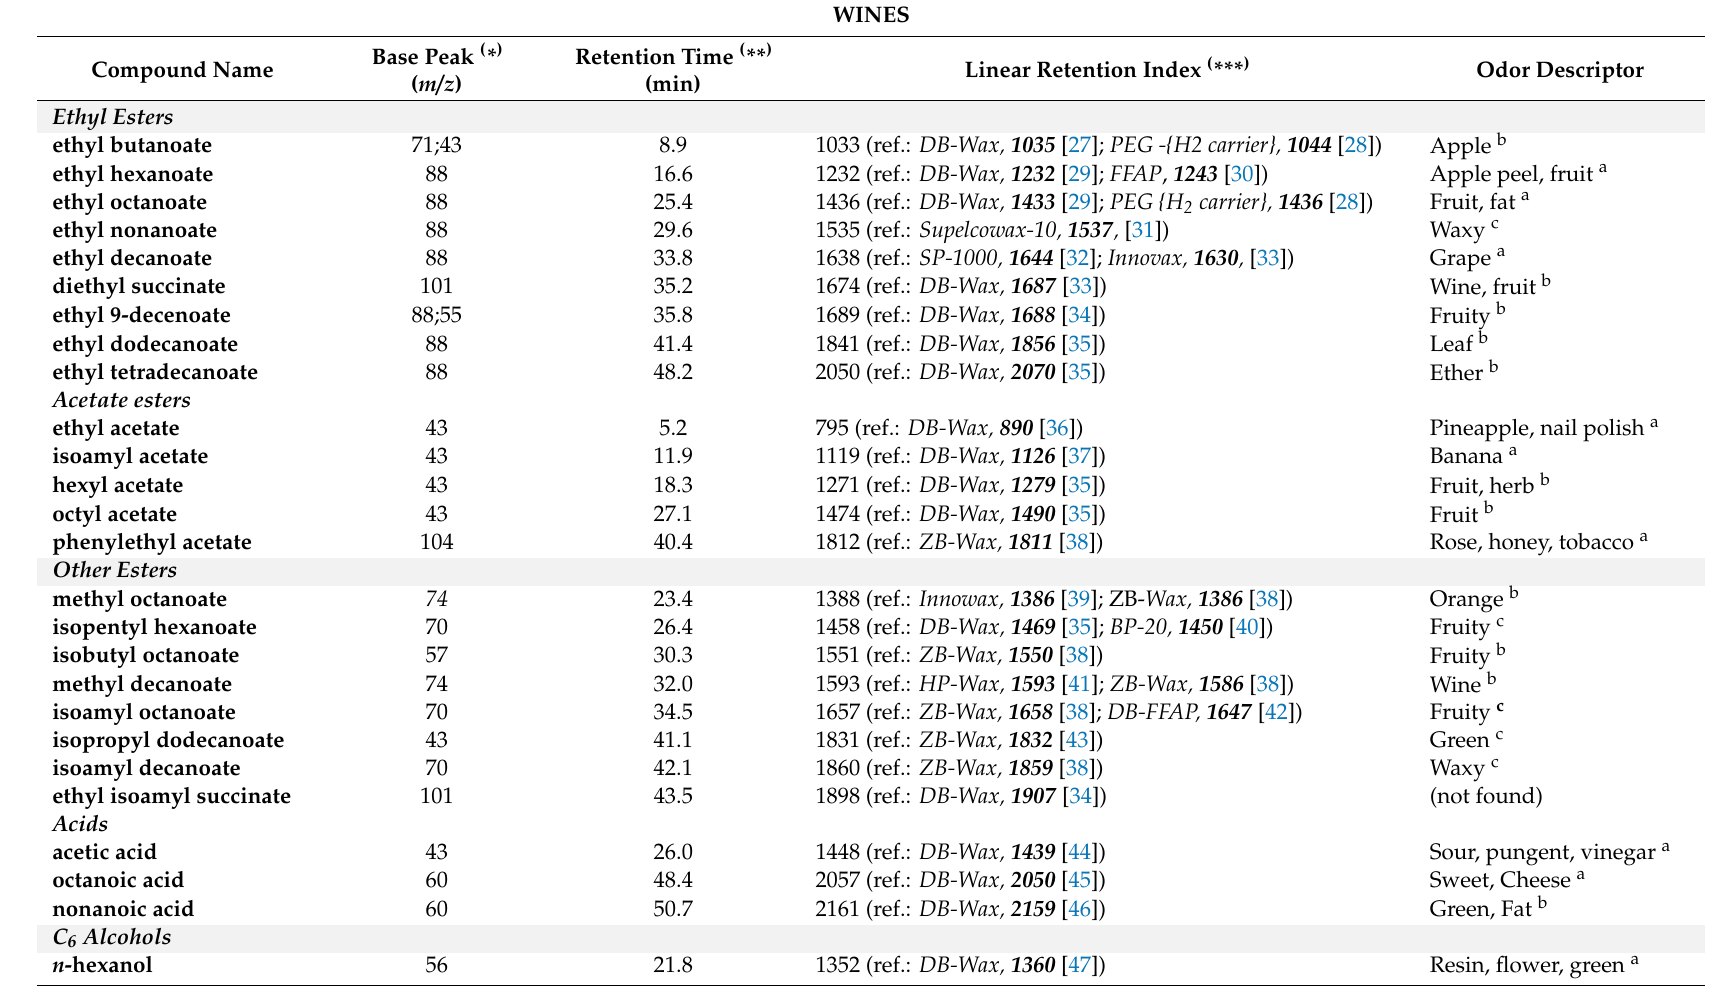
Table 3. List of volatile compounds identified by HS-SPME-GC / MS in Pinot